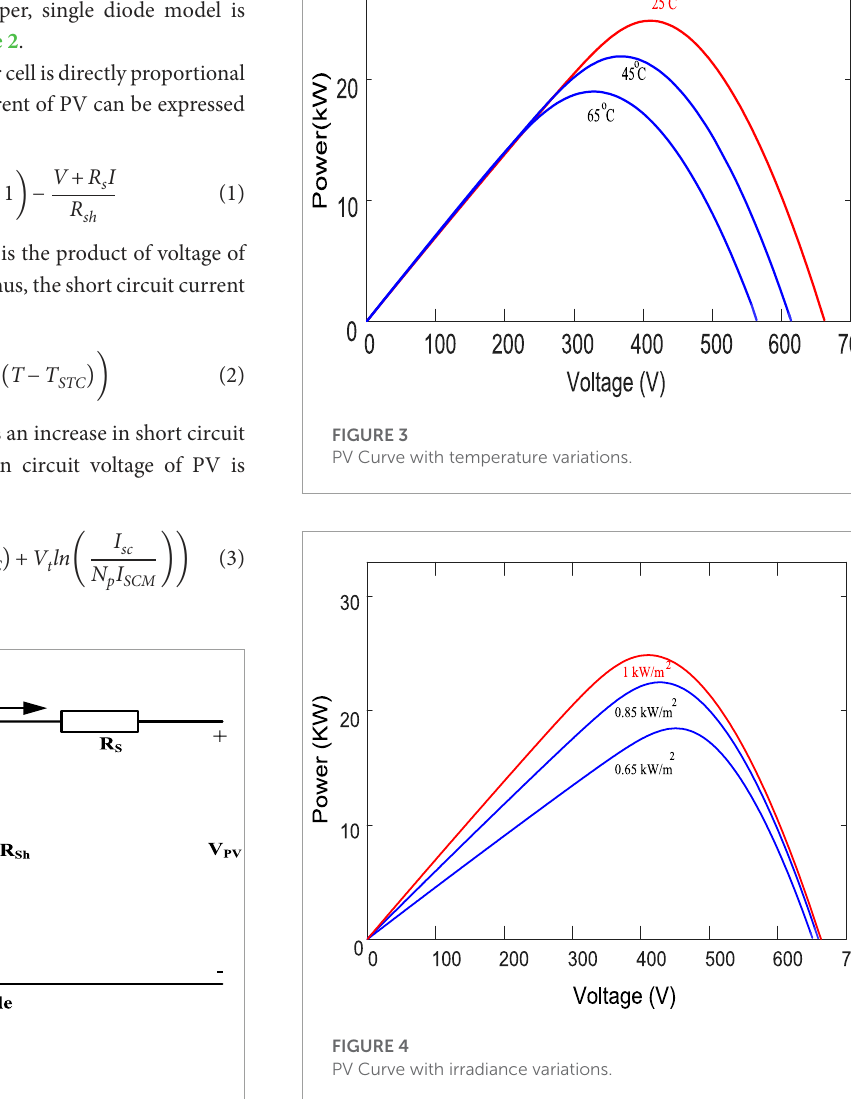
FIGURE 4 PV Curve with irradiance